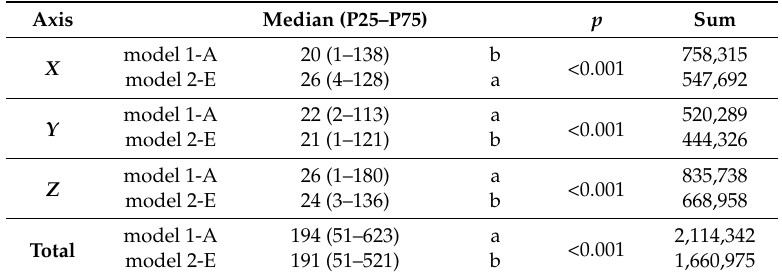
Table 4. Comparison of the values of the square of the X-deviation, Y-deviation, Z-deviation, and the total in the impressions of the groups of closed tray impression with replacement abutments, without and with angulation (groups A and E, respectively).